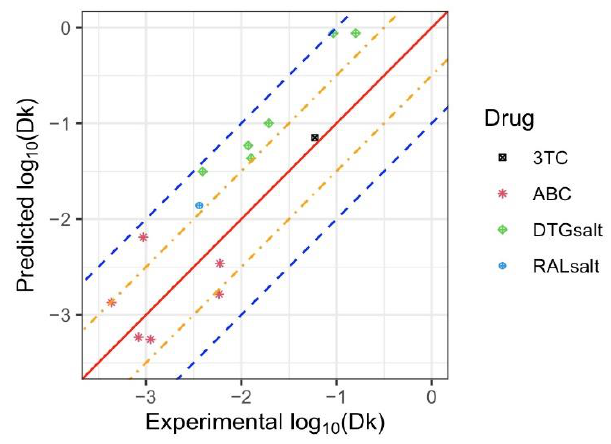
Figure 4. Predicted and experimental values of log (𝐷𝑘) for 3TC, ABC, DTG salt , and RAL salt . The solid red diagonal line indicates when the prediction and observation are the same, the orange and blue dashed lines indicate predictive values within 0.5 log and 1 log of the observed values, respectively. Different symbols represent each drug, with multiple points for the same symbol representing different implant configurations tested for each drug.